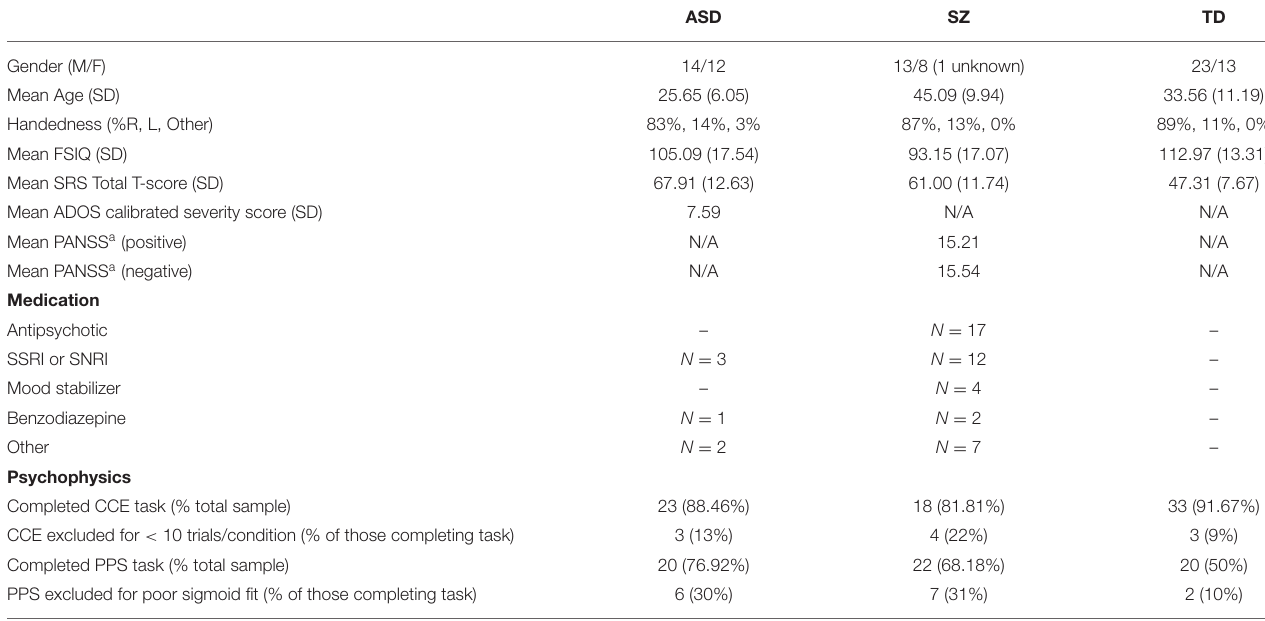
TABLE 1 | Sample and psychophysics paradigm subsample descriptive